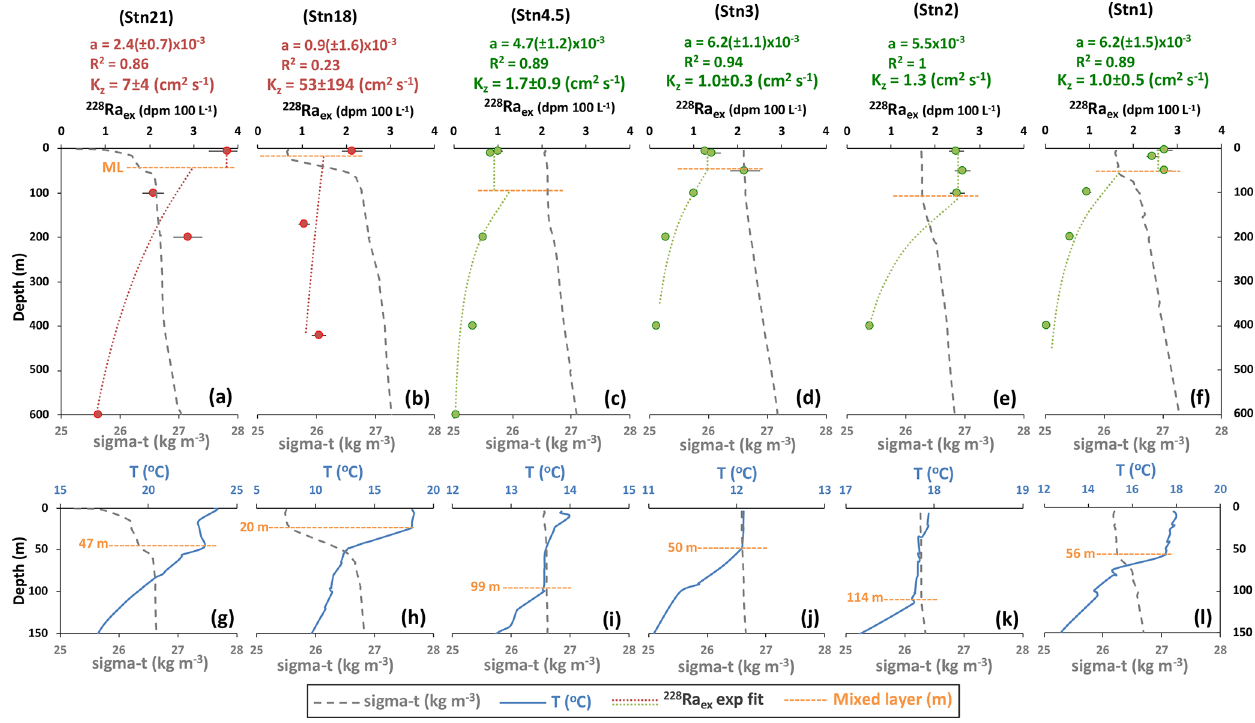
Figure 6. Depth profiles of (a–f) seawater 228 Ra ex activity in red (Argentine Basin) and green (Cape Basin) circles and density (sigma- t ) shown in dashed grey lines, and (g–i) density and temperature in the upper ocean shown at Stn1, 2, 3, 4.5, 18, and 21. Depths of the mixed layer are labelled with the horizontal dashed orange lines, defined by the sigma- t and temperature profiles. The dashed red and green lines show exponential regression trends through the 228 Ra ex data below the mixed layer (including the average value of the mixed layer). The gradients of the exponential fit (the a values) are used in Eq. (5) for the K z calculation (errors ± 1SD). Table 3. 228 Ra-derived vertical dTE fluxes along the 40 ◦ S Atlantic transect ∗ . dTE flux dCo dFe dZn (nmolm − 2 d − 1 ) (nmolm − 2 d − 1 ) (nmolm − 2 d − 1 ) Stn1 (JC068) 0.6 ± 0.3 11 ± 6 7 ± 5 Stn1 (D357) 0.3 ± 0.2 on ti Stn3 (JC068) 0.1 ± 0.1 6 ± 2 5 ± 3 a S t Stn3 (D357) 0.7 ±